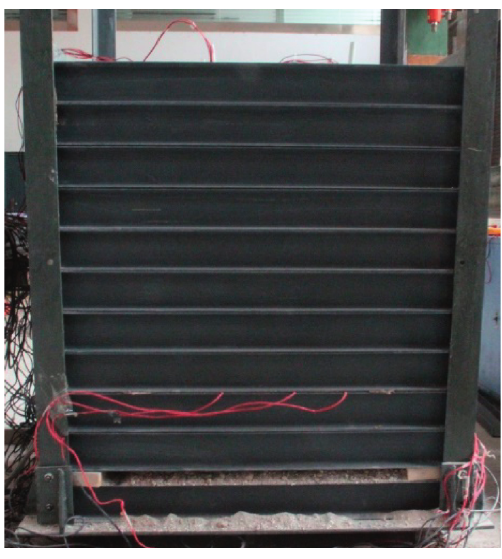
Figure 8: Coalface at